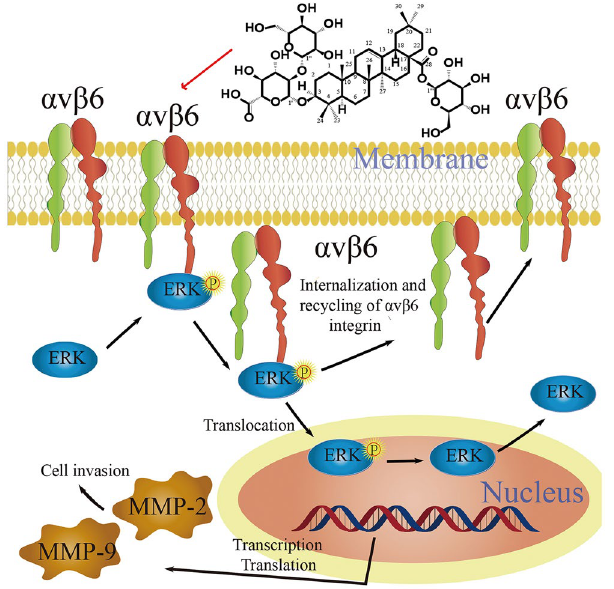
Figure 7. The possible mechanism underlying the inhibition by ginsenoside Ro of cancer cell invasion and metastasis. Ginsenoside Ro inhibits integrin α v β 6 and phosphorylation of ERK, which further results in inhibition of the formation of integrin β 6/ ERK complex intracellularly. The inhibition of ERK phosphorylation somehow reduces the expression of MMP-2 and MMP-9. Together, the adhesion, invasion and metastatic ability of cancer cells are